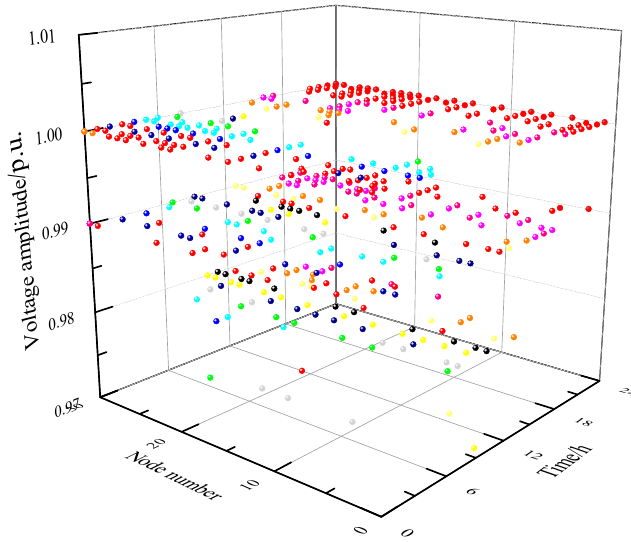
Figure 7. Voltage amplitude of main nodes.